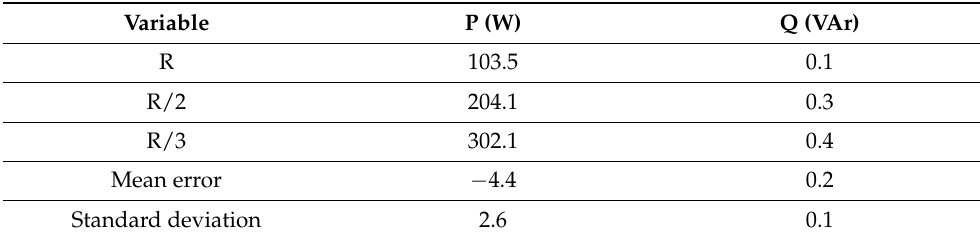
Table 3. Powers obtained by Yokogawa ® for scenario 1.